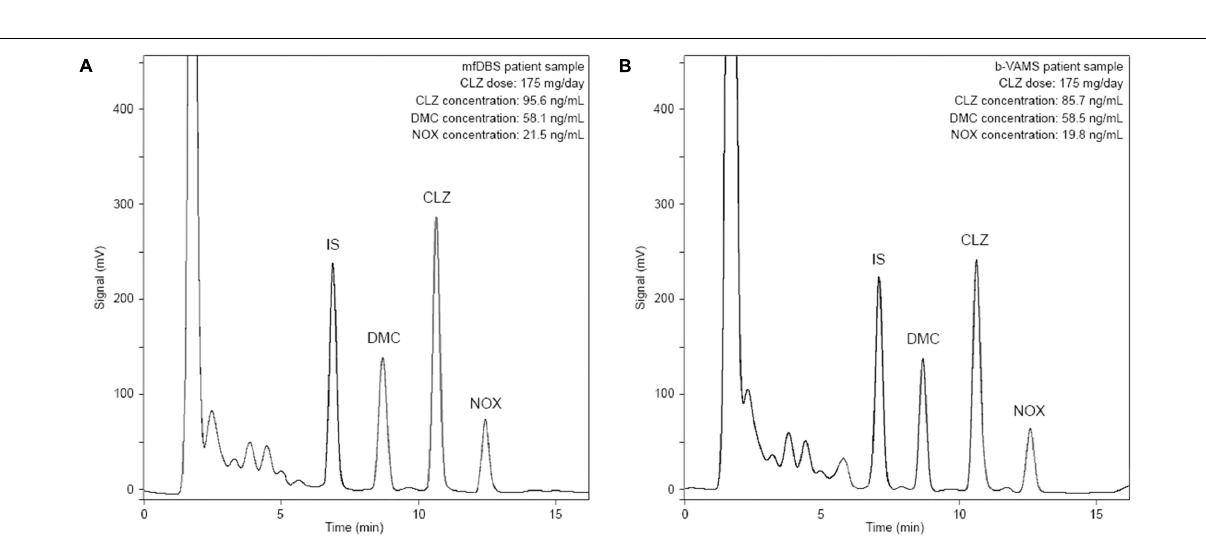
Frontiers in Psychiatry |